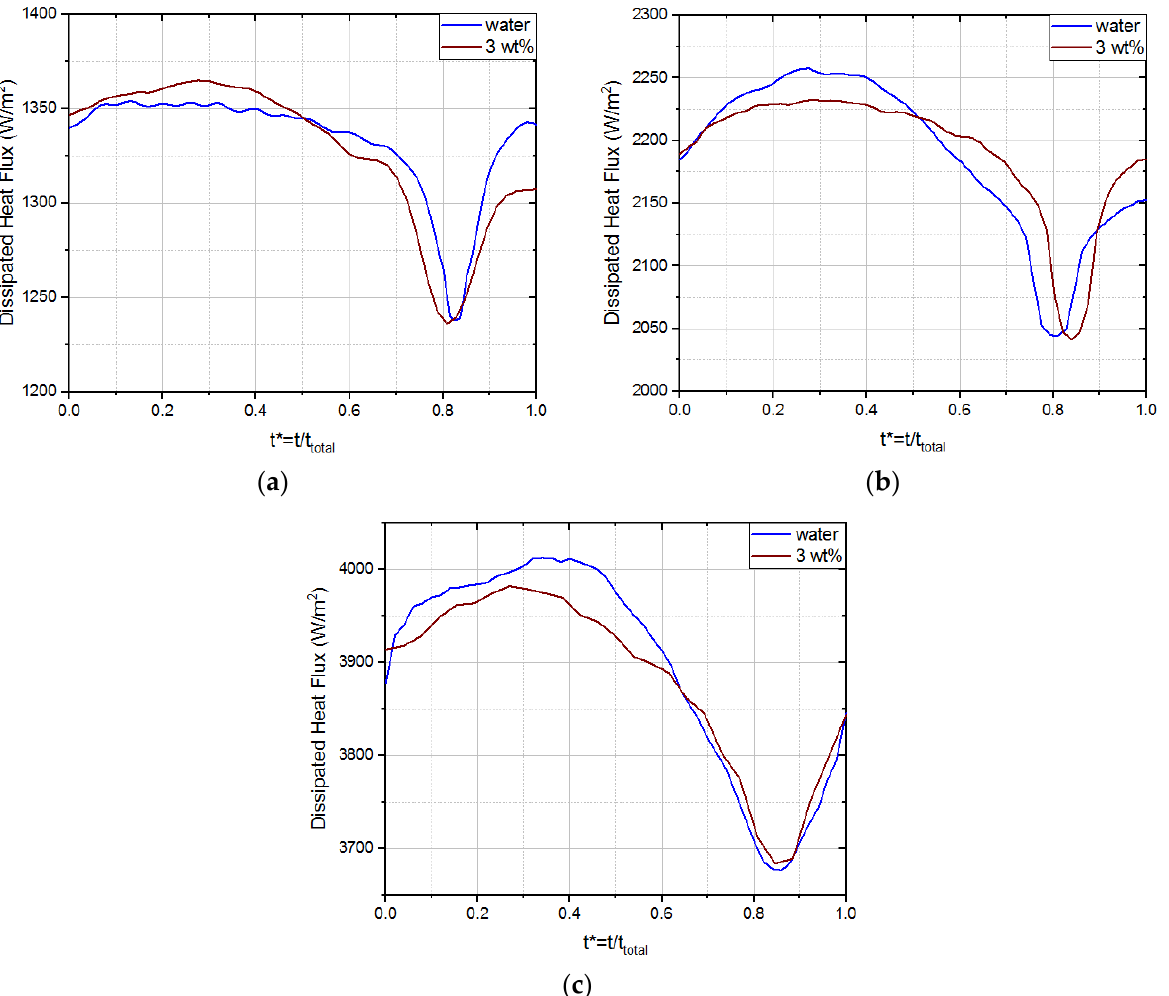
Figure 4. Average dissipated heat flux for a nucleation time frame, for different imposed heat fluxes, using water and 3 wt% concentration Al 2 O 3 /water nanofluid. The superhydrophobic region is 1.5 mm in diameter. ( a ) 1290 W/m 2 (7 A). ( b ) 2132 W/m 2 (9 A). ( c ) 3790 W/m 2 (12 A).